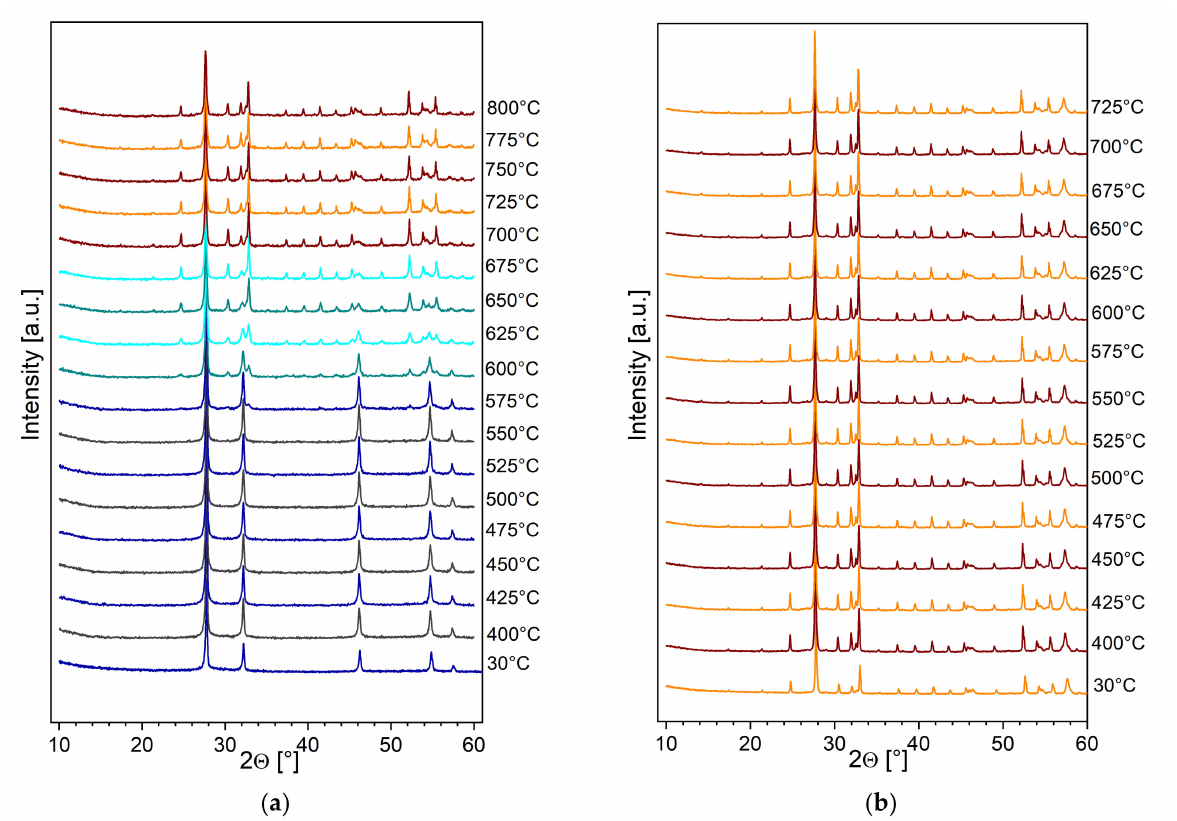
Figure A2. ( a ) Thermal evolution of XRD patterns of a sample prepared in ceramic crucible at 1000 ◦ C and freely cooled during heating up to 800 ◦ C. ( b ) Thermal evolution of the same sample during cooling down to room temperature. Blue and gray colors correspond to δ -like phase (fluorite structure); turquoise color indicates phase transition to γ -like phase; orange and maroon colors correspond to γ -like phase stability